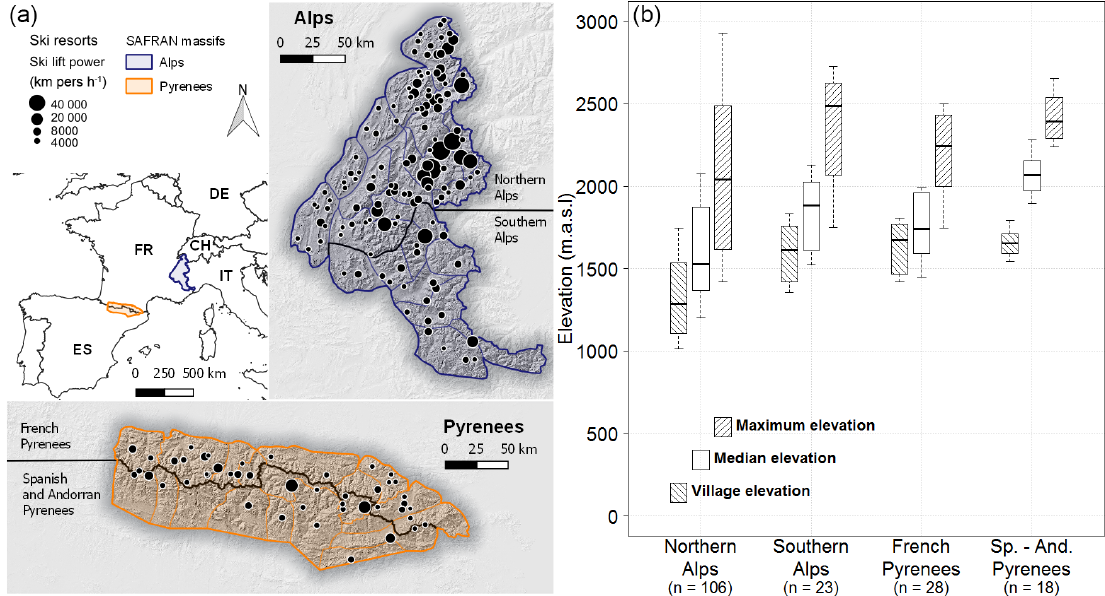
Figure 2. (a) The 175 ski resorts covered by the present study and the 44 massifs from the SAFRAN reanalysis and (b) distribution of ski resort elevations depending on their location: northern Alps, southern Alps, French Pyrenees, and Spanish and Andorran Pyrenees (“Sp.–And. Pyrenees”). See Appendix